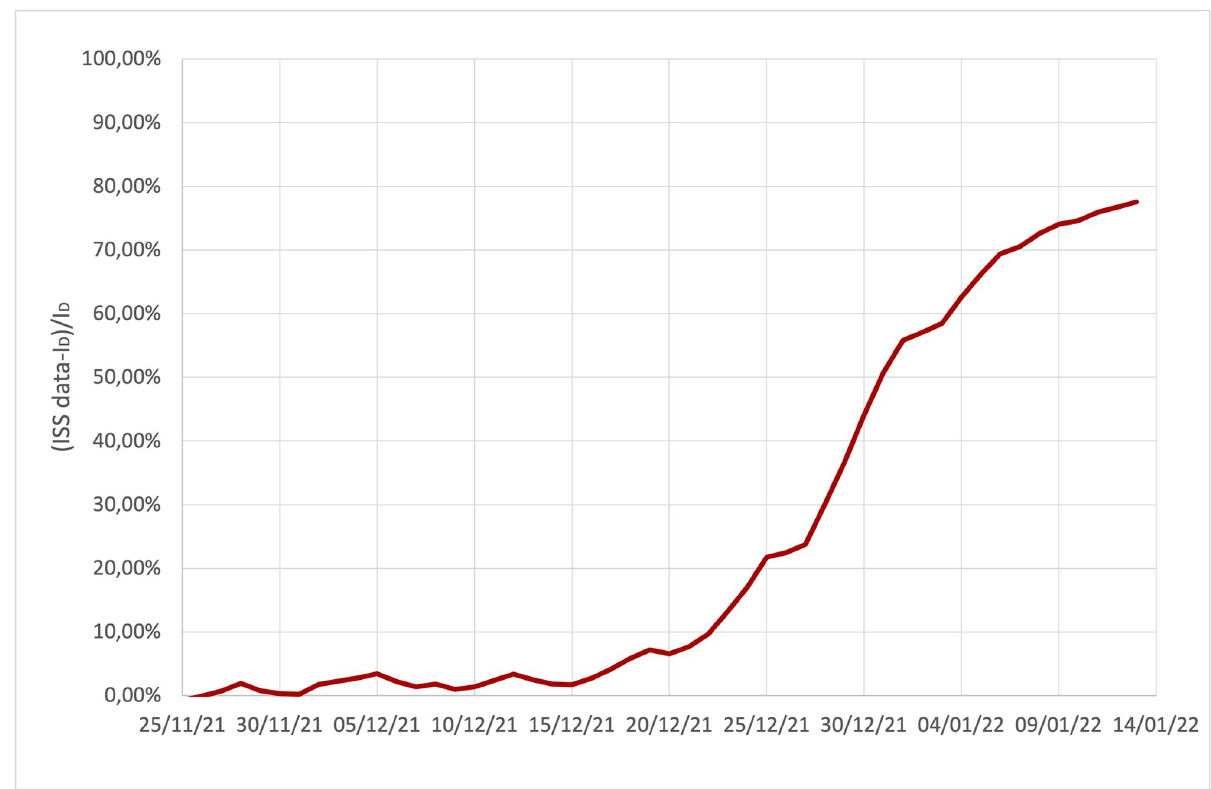
Fig 7. Discrepancy between the diagnosed active case provided by ISS and the simulated data, I D , during the insurgence of the Omicron variant.